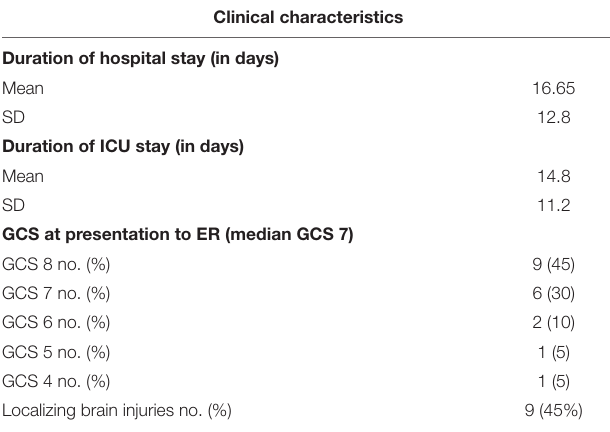
TABLE 2 | Clinical characteristics. Clinical characteristics